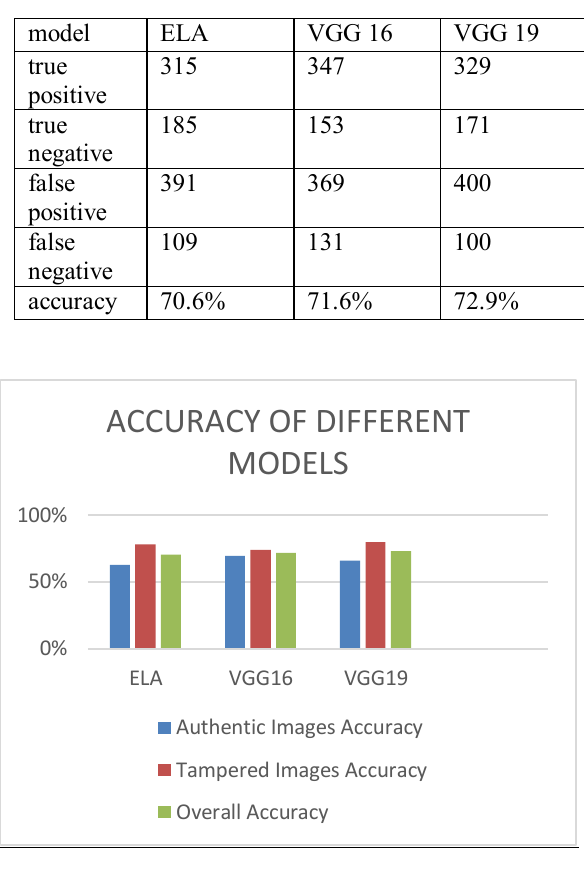
Figure 5. Accuracy comparison of different